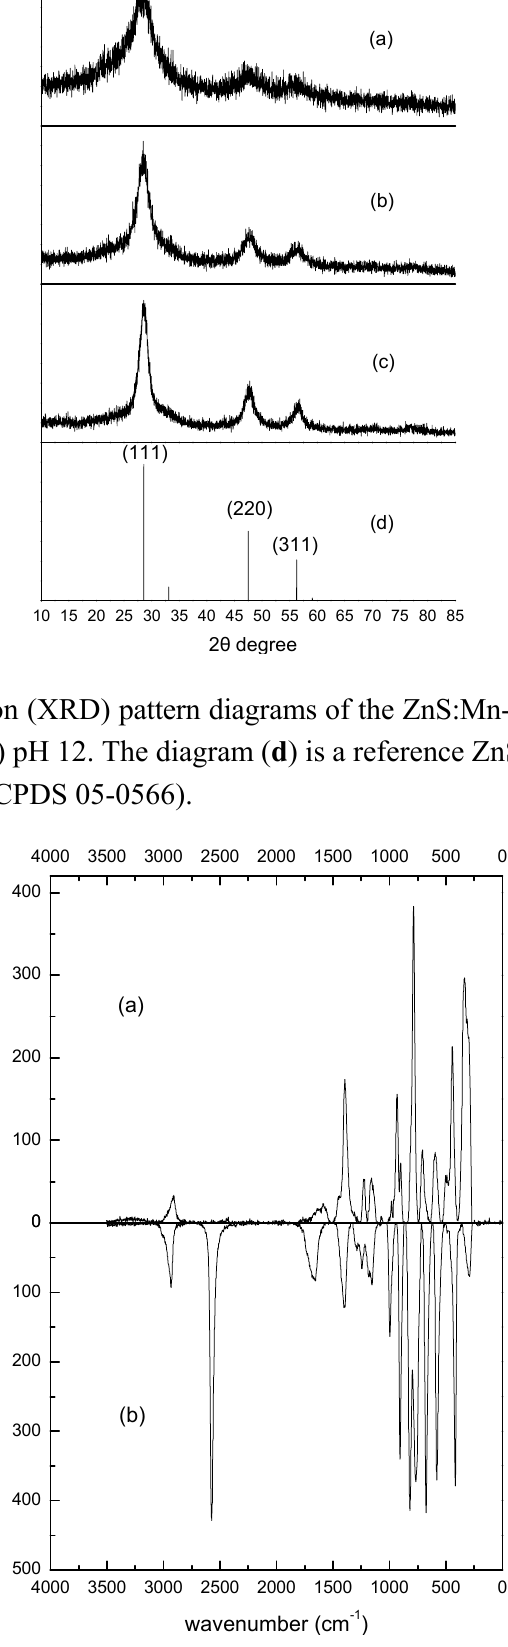
Figure 5. Fourier transform (FT) -Raman spectra of the: ( a ) ZnS:Mn-MAA NC (pH 12); and ( b ) Neat MAA